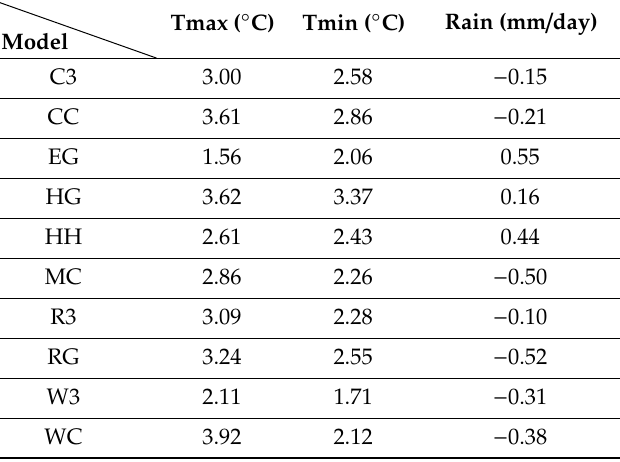
Table 3. Projected area-average maximum temperature, minimum temperature, and rainfall di ff erences between future (2041–2070) and current (1971–2000) NARCCAP runs.